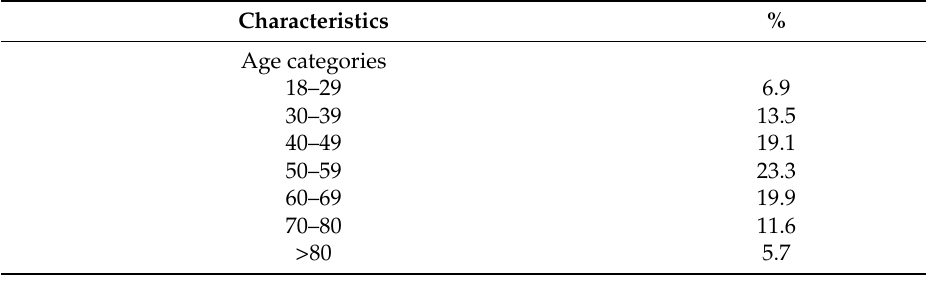
Table 1. Characteristics of the survey respondents ( n = 4336). Results are not